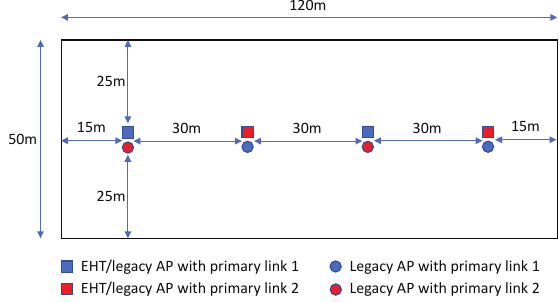
Figure 7. 3GPP indoor deployment